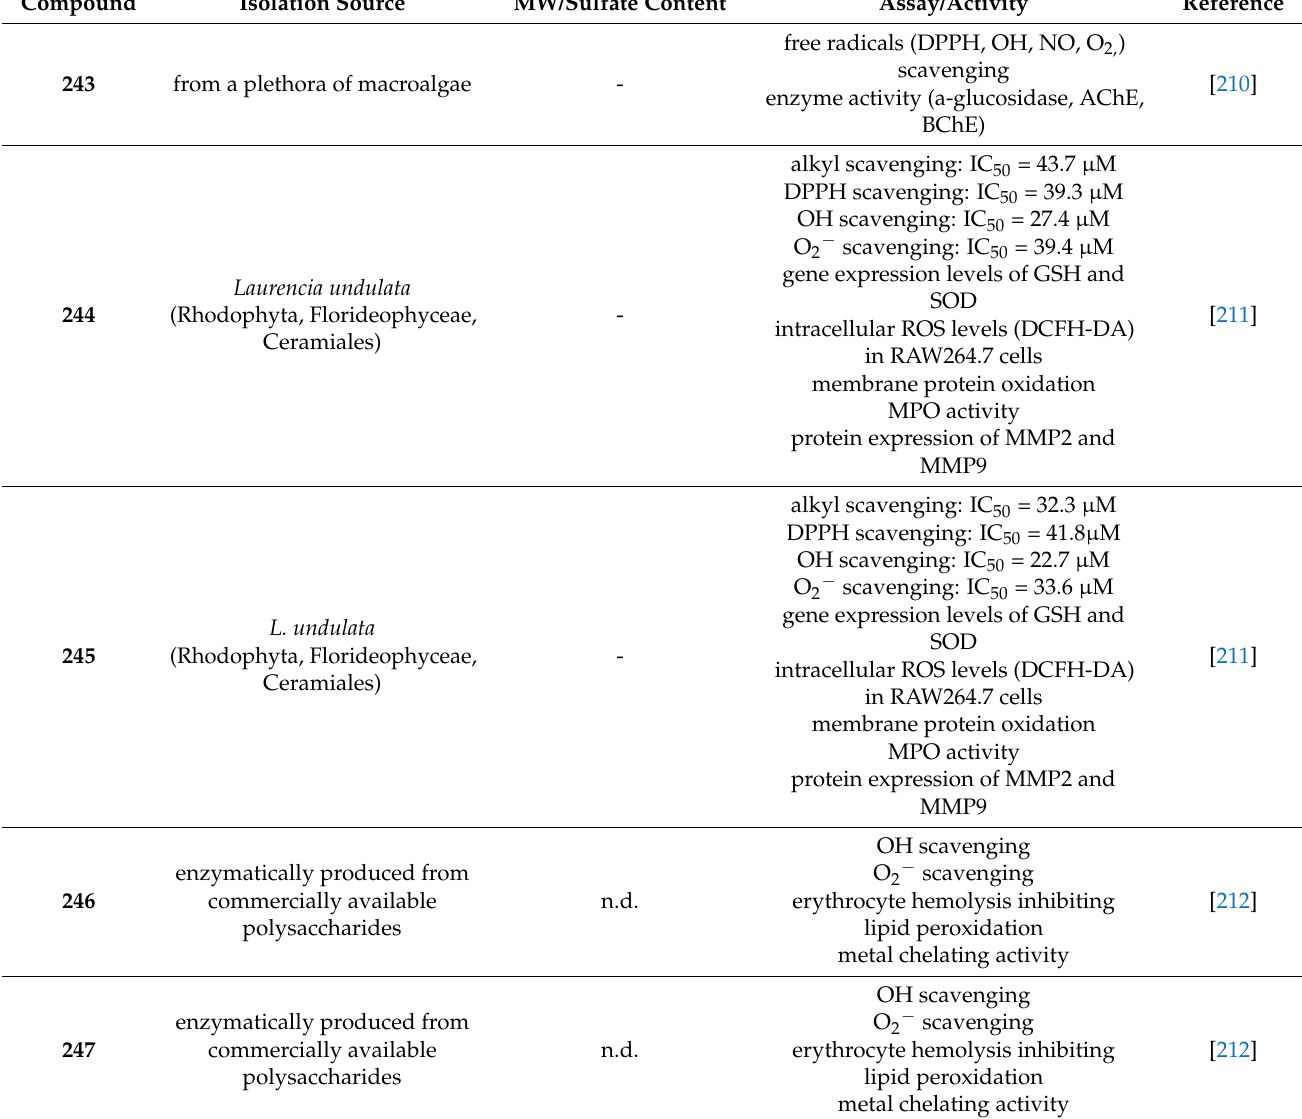
Table 6. Carbohydrates and polysaccharides from macroalgae with antioxidant